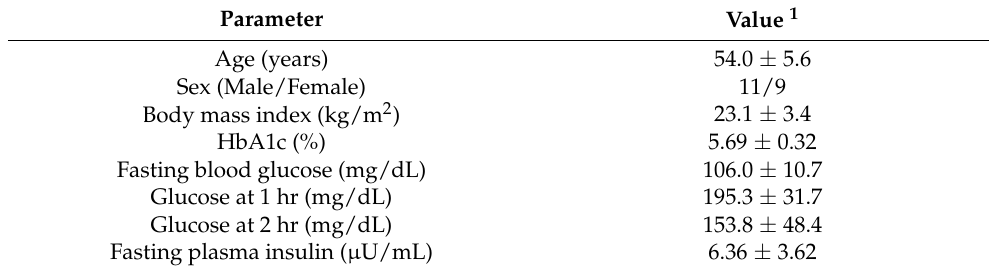
Table 2. Subject characteristics at the screening visit ( n = 20). The data are expressed as mean ± standard deviation or